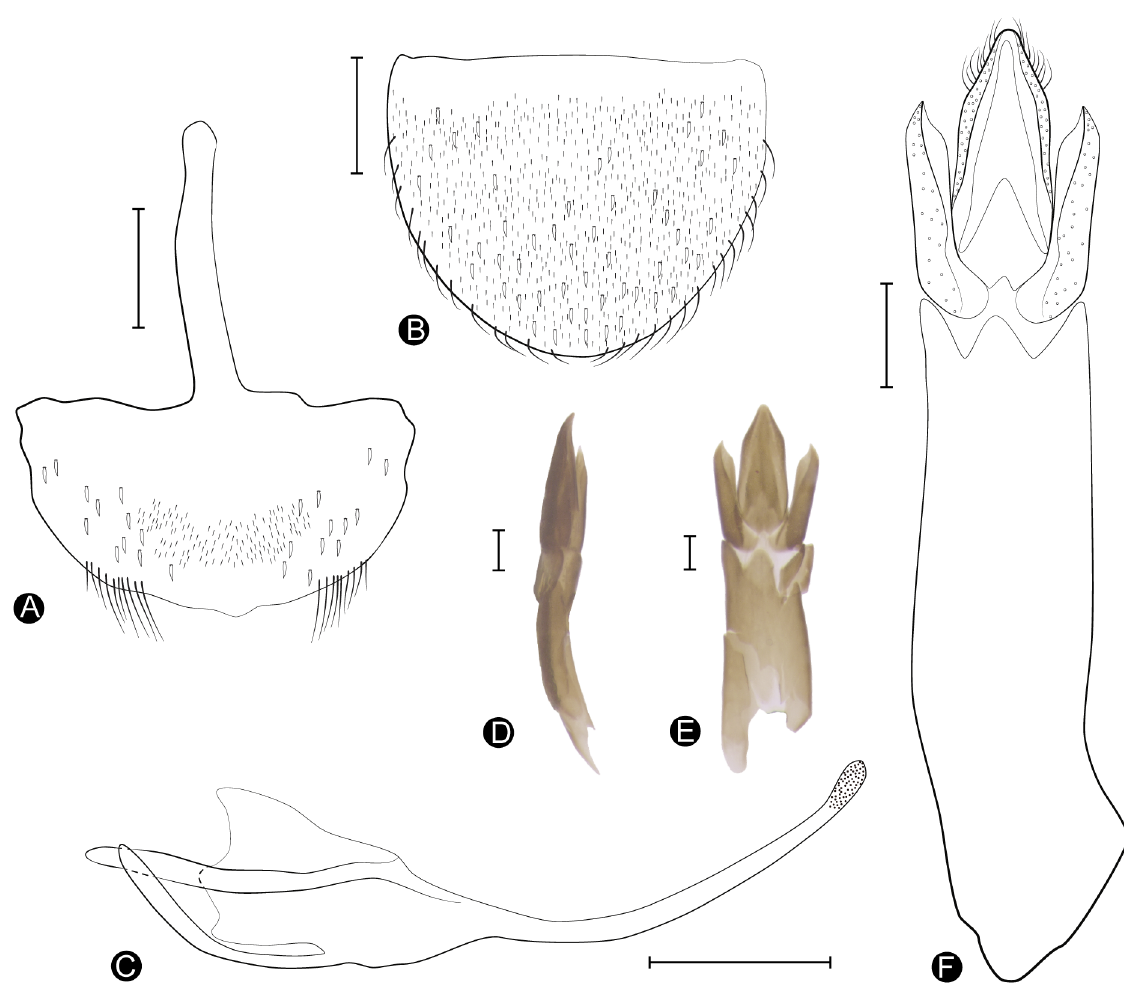
Fig. 4. Spanglerelmis xiririca Polizei & Bispo gen. et sp. nov. ♂. A . Sternite VIII. B . Tergite VIII. C . Segment IX (MZSP31453). D . Aedeagus in lateral view. E – F . Aedeagus in ventral view (MZSP31444). Scale bars = 0.1